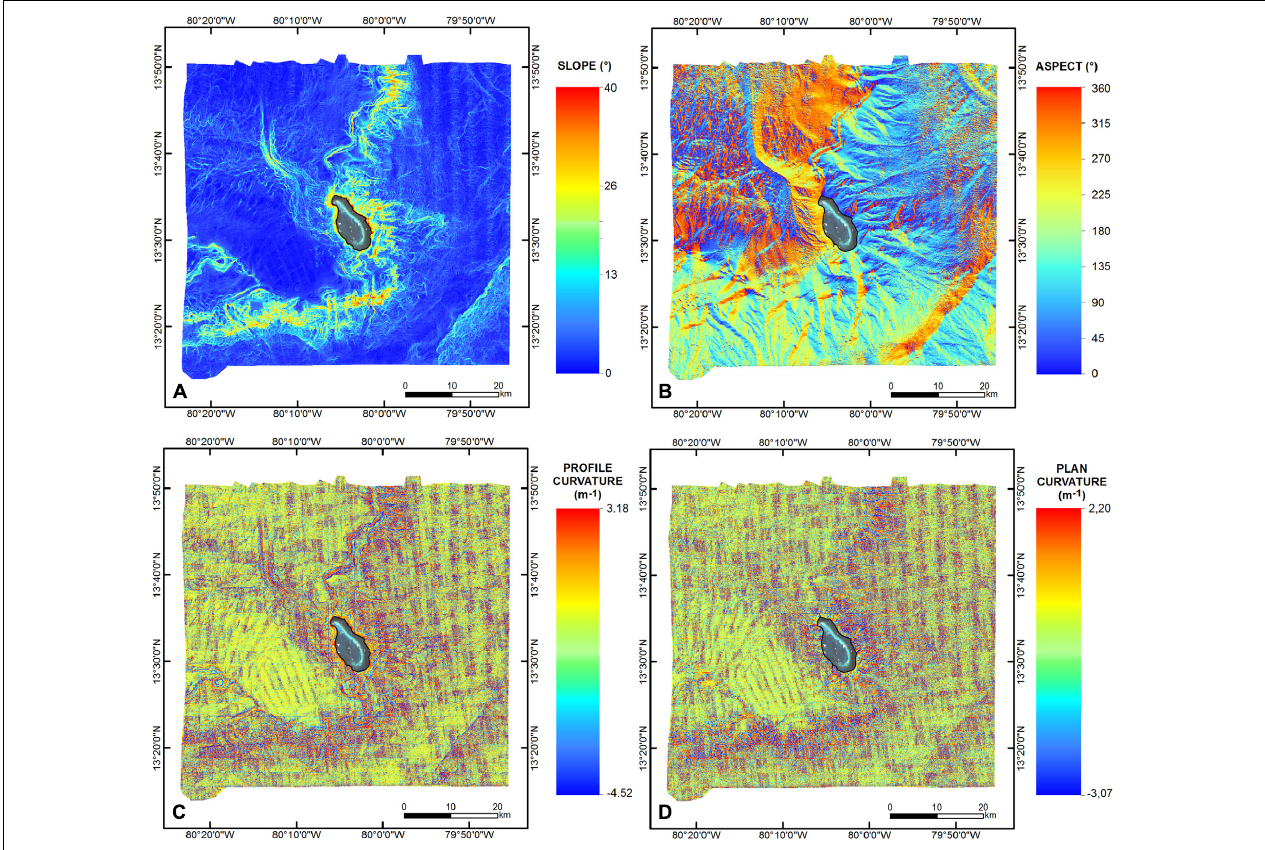
FIGURE 3 | (A) Terrain slope model, where a zone exhibiting the steepest slope angles bounds Roncador seamount to the south and east. (B) Aspect (or slope direction) model. (C) Profile curvature model. (D) Plan curvature model. The satellite image covers the reef constructions shallower than –40 m and the permanently emerged areas